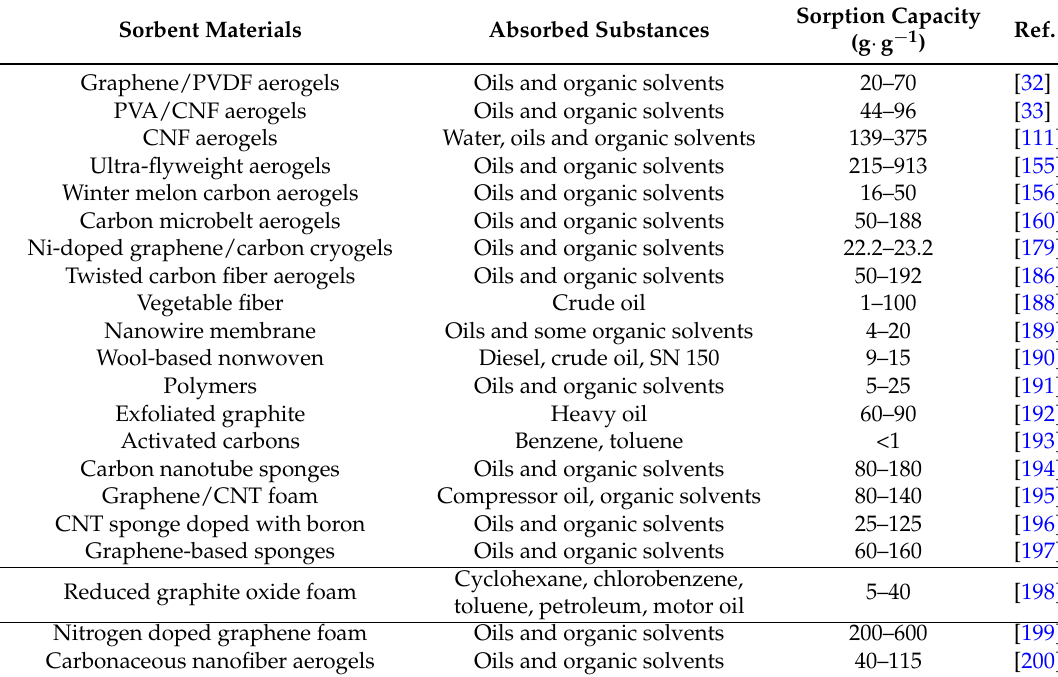
Table 1. Comparison of various aerogel materials for